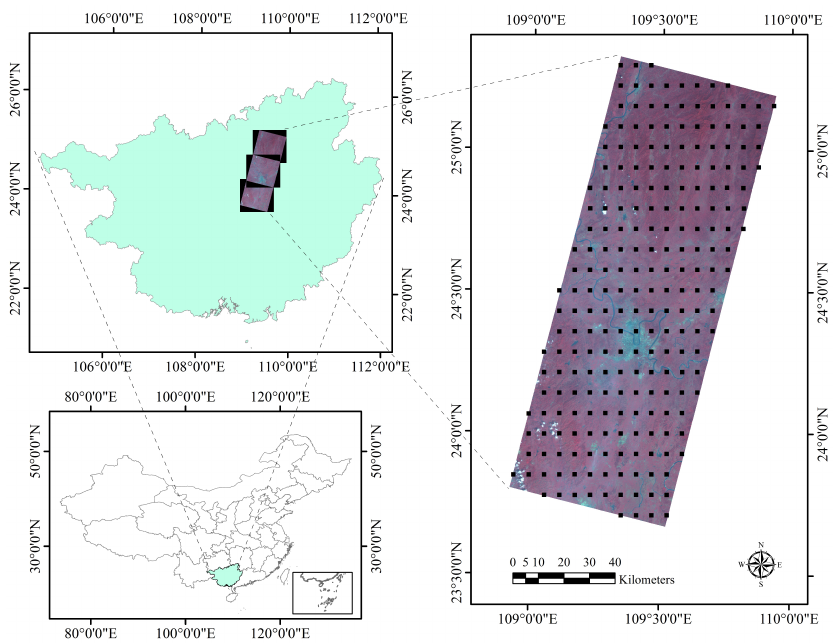
Figure 1. Geographical location of the study area and the images and sampling plots used in the